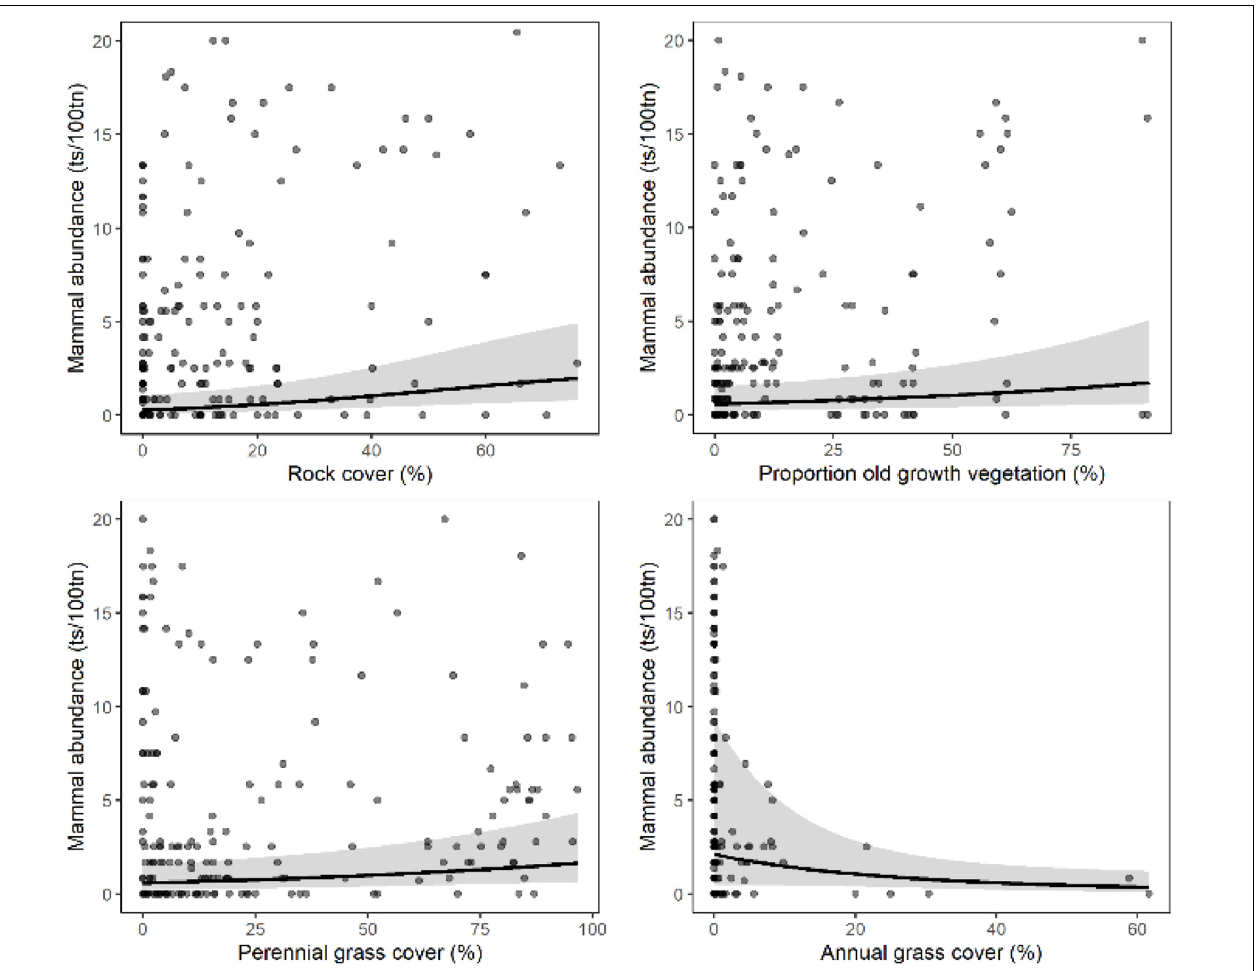
FIGURE 4 | Mammal abundance [trap success per 100 trap nights (ts/100tn)] in volcanic habitat shown only for highly influential predictor variables sampled at the 3 km scale around each site (see Table 2 ). Relationships for each variable were derived from GLMM predictions while holding other explanatory variables constant at their median level. Model fit is shown by a black line and the gray band represents the 95% confidence interval. Gray circles indicate observed data values and are darker when repeated observations occur at the same